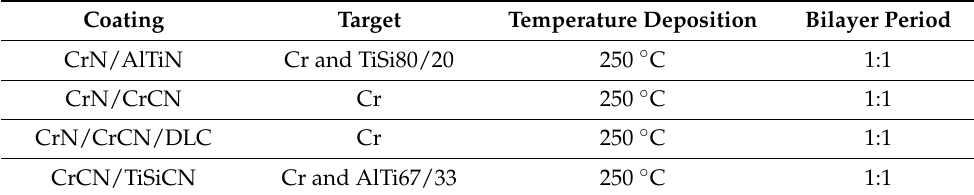
Table 1. Target material, temperature deposition and bilayer periods of the coatings deposited at Aurora